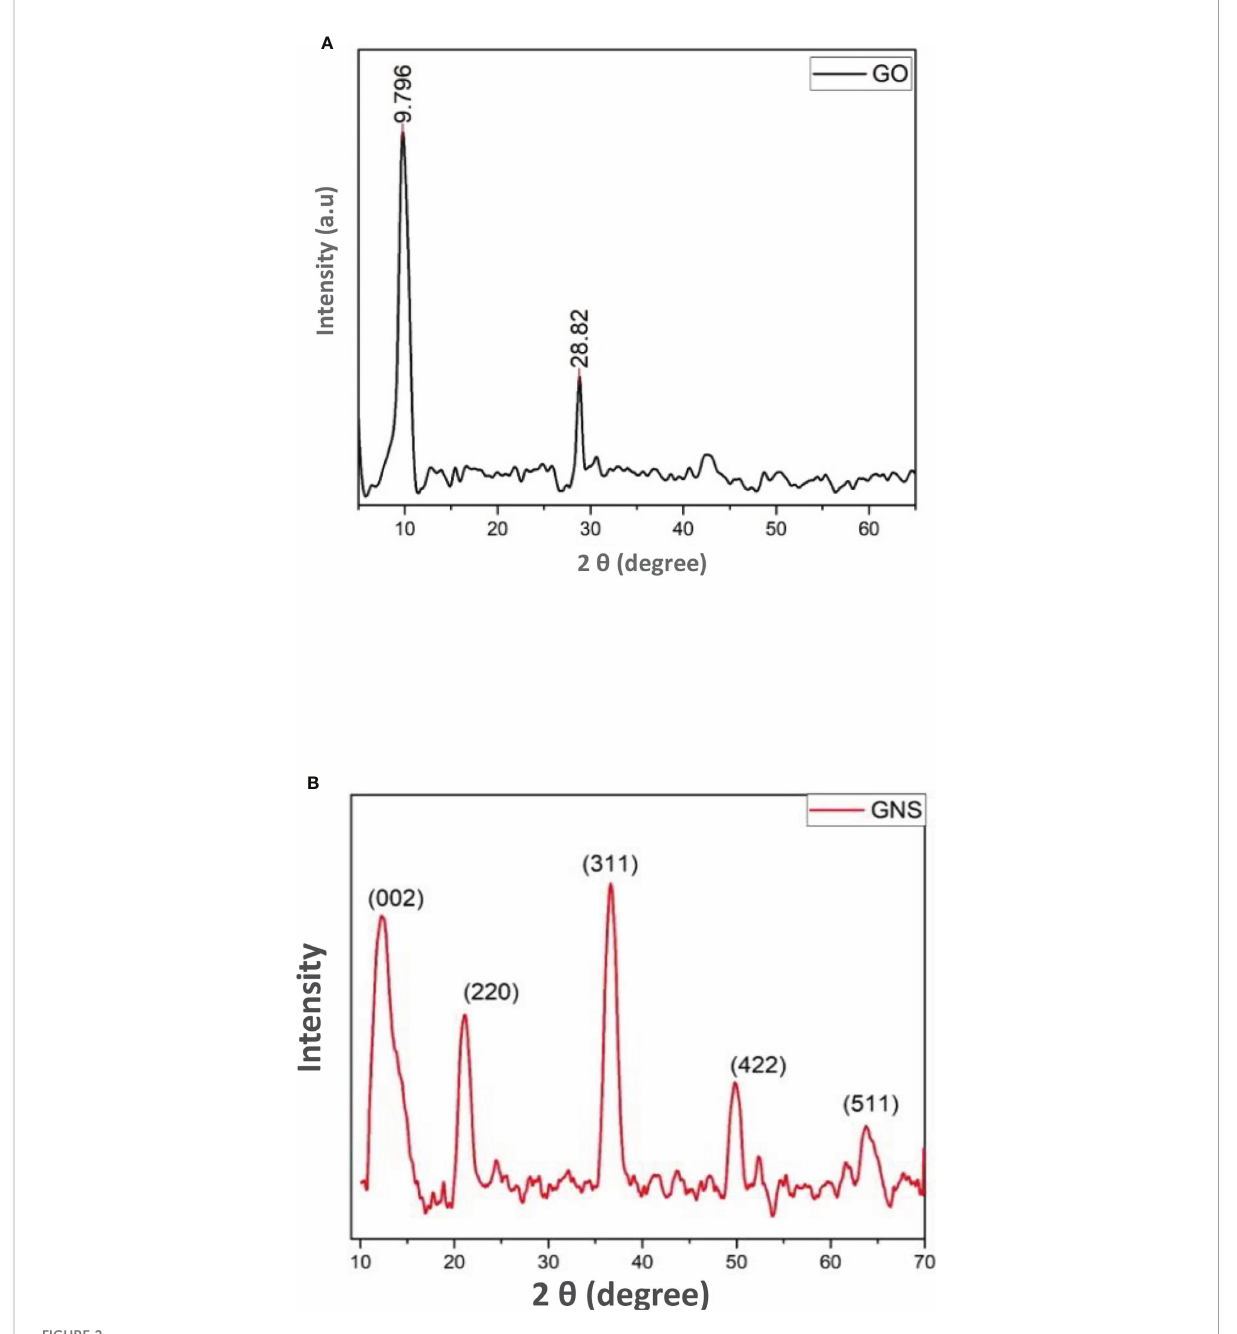
FIGURE 2 (A) = XRD pattern of synthesized graphene oxide; (B) = XRD pattern of green synthesized graphene oxide